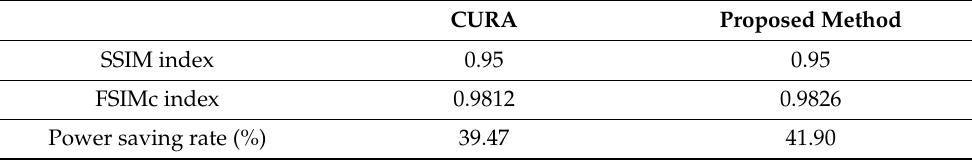
Table 4. Comparison of image quality indices and power savings.